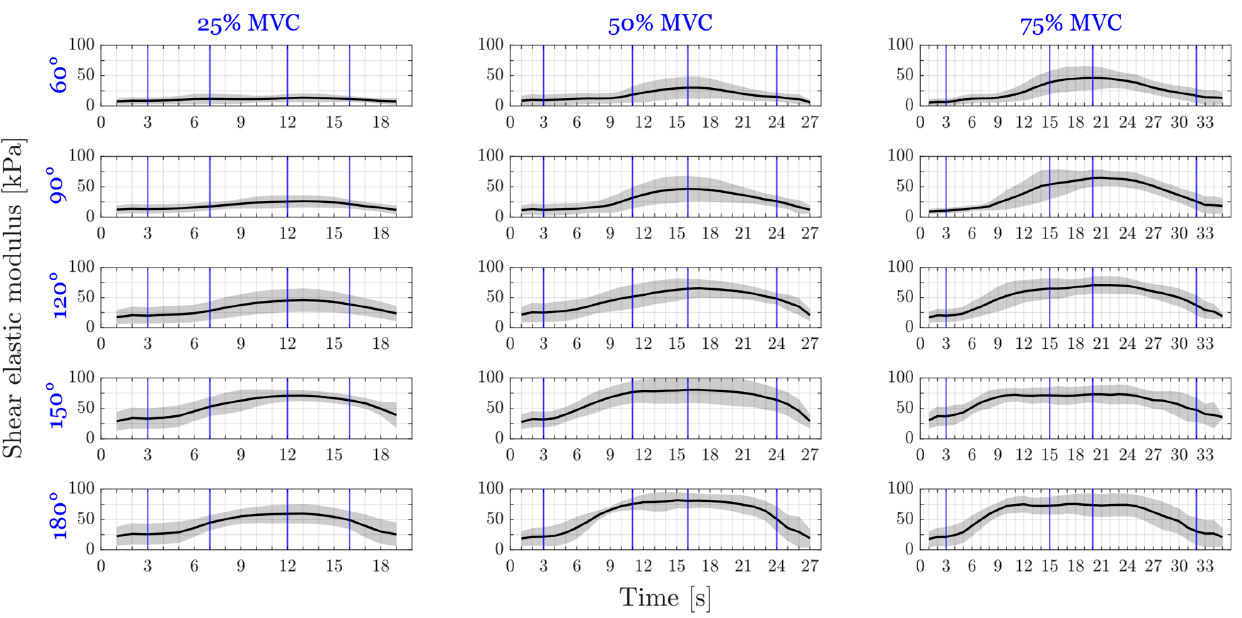
Figure 3. Average total shear elastic modulus of the biceps brachii muscle during elbow fl exion isometric ramp contraction trials with standard deviation (in light grey shades). Columns show the three contraction intensities with a constant level up to 25%, 50% and 75% of maximum voluntary (MVC) elbow torque, rows show the fi ve elbow angles studied (60°, 90°, 120°, 150° and 180°). Vertical blue lines indicate the di ff erent sections of the trapezoid line to be followed.